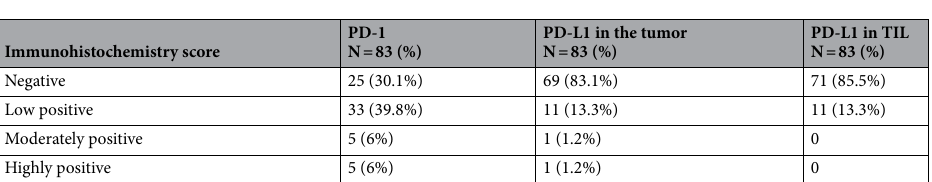
Table 1. Frequency of PD-1 and PD-L1 in 83 gallbladder cancer patients. PD-1 Programmed cell death protein 1, PD-L1 programmed death-ligand 1, TIL tumor-infiltrating lymphocytes.